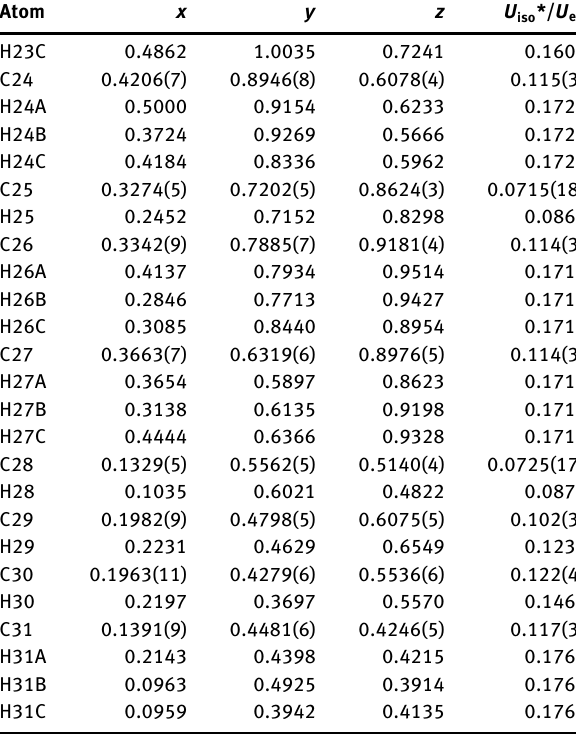
Table 2: Fractional atomic coordinates and isotropic or equivalent isotropic displacement parameters (Å 2